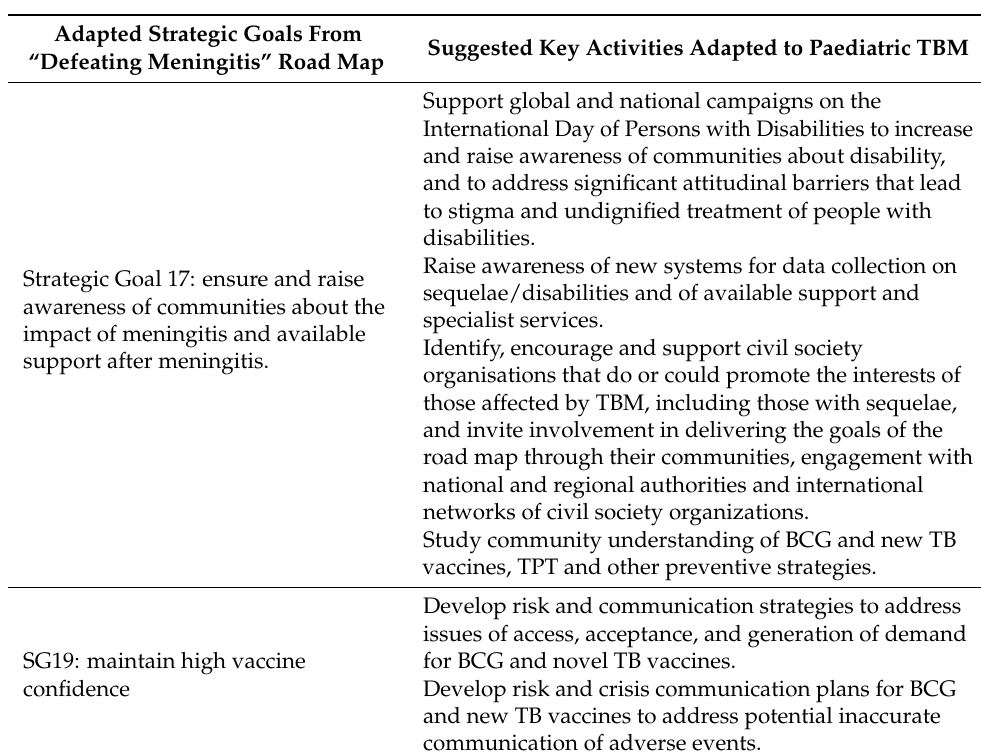
Table 6. Cont . Adapted Strategic Goals From “Defeating Meningitis” Road